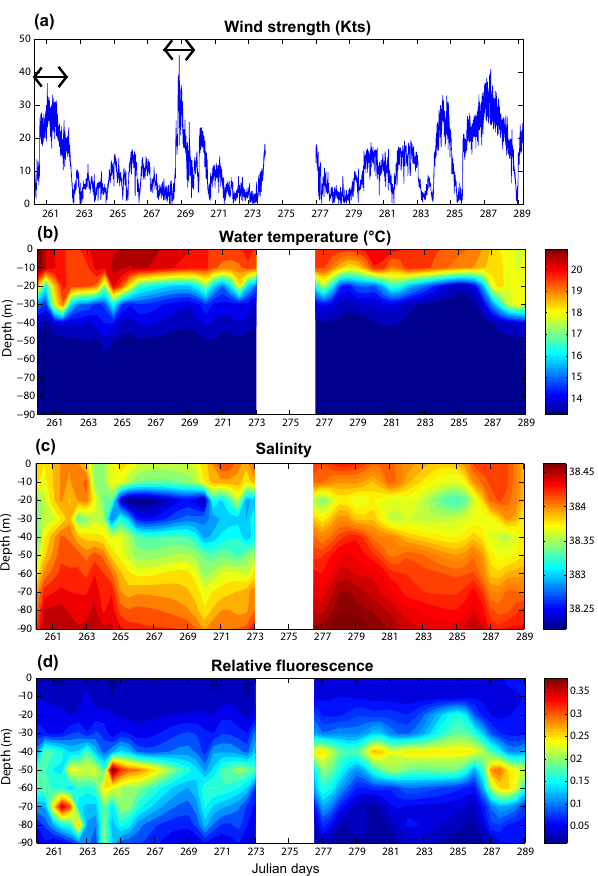
Fig. 1. Hydrological conditions during DYNAPROC 2 cruise, (a) Wind strength, (b) Water temperature, (c) Salinity, (d) Relative